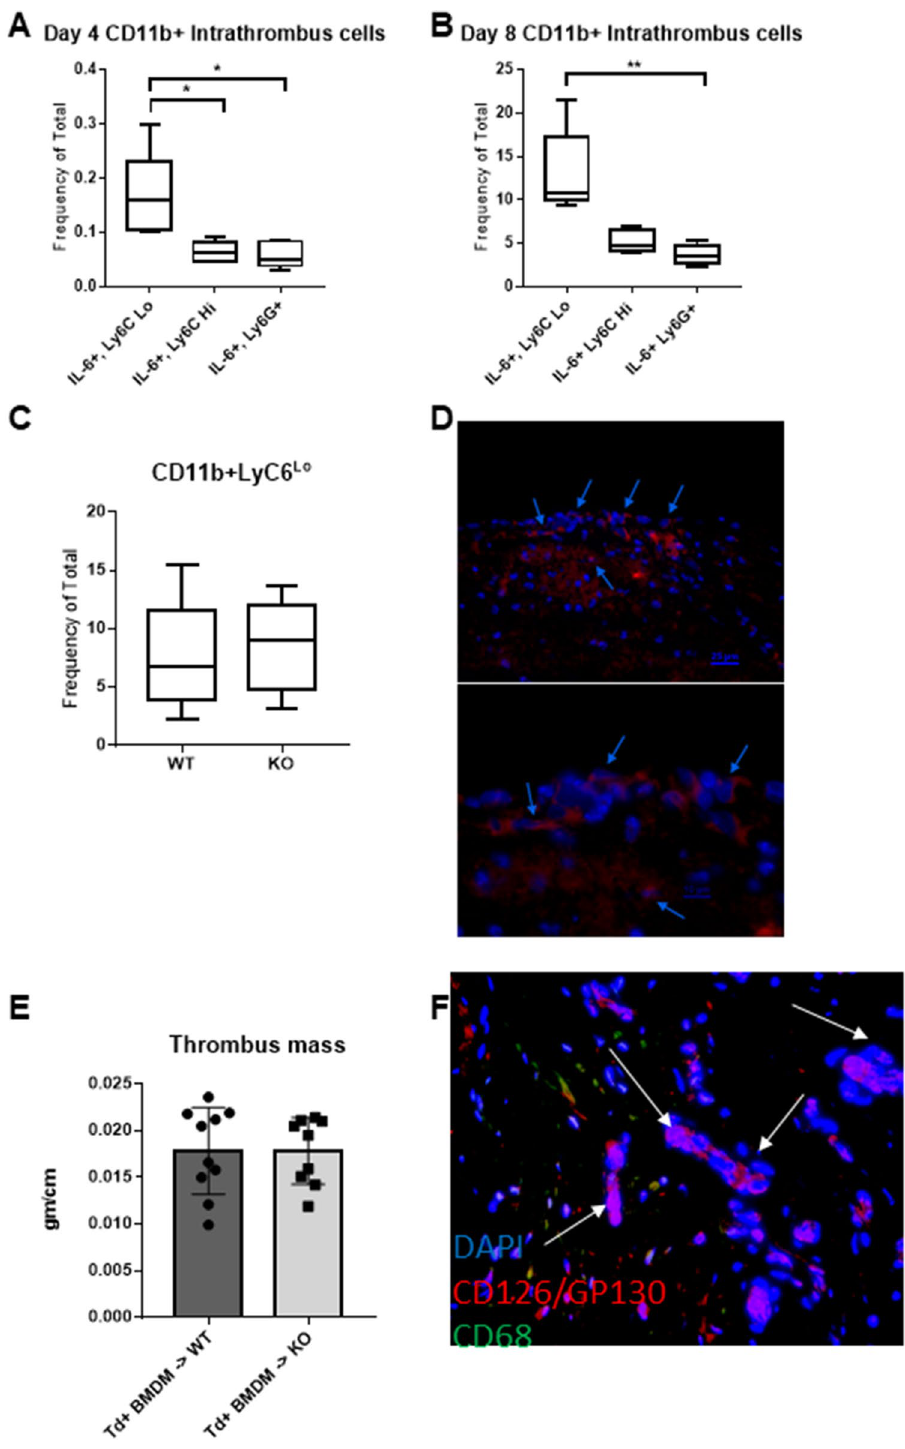
Figure 3. Adoptive transfer of the primary IL-6 + leukocyte within the thrombus restores normal thrombus resolution. At 4 and 8 days following IVC ligation, thrombus was isolated, digested and sorted by flow cytometry to identify leukocyte source of IL-6. The frequency of IL-6 + (CD11b + [CD3-CD19-Ter119-NK1.1-]Ly6C lo and Ly6C hi monocytes and Ly6G + neutrophils within thrombus at day 4 ( A ) and day 8 ( B ). The frequency of Ly6C lo (CD11b + CD3-CD19-Ter119-NK1.1-) cells in WT compared to IL-6 −/− mice at 8 days post thrombosis is shown in ( C ). Adoptive transfer of monocytes from mTmG mice was performed into WT and IL-6 −/− mice on day 4 post thrombosis. ( D ) Representative immunofluorescence microscopy of thrombus 4 days following adoptive transfer in WT mouse, blue arrows denote Td red monocytes counterstained with DAPI in day 8 thrombus. ( E ) Thrombus mass measured 4 days following adoptive transfer. ( F ) Immunofluorescence microscopy at 100 × of human chronic DVT specimens . White arrows denote cells co-staining with DAPI (blue), CD68 (green) and gp130 (red). The image is representative of 3 patient histologic samples. All data presented as mean ± standard deviation. Normally distributed data was compared utilizing unpaired student’s test with Welch’s correction and non-normally distributed data compared with Mann–Whitney U test. For comparisons across > 2 groups, Kruskal– Wallis testing was performed *p < 0.05, **p <